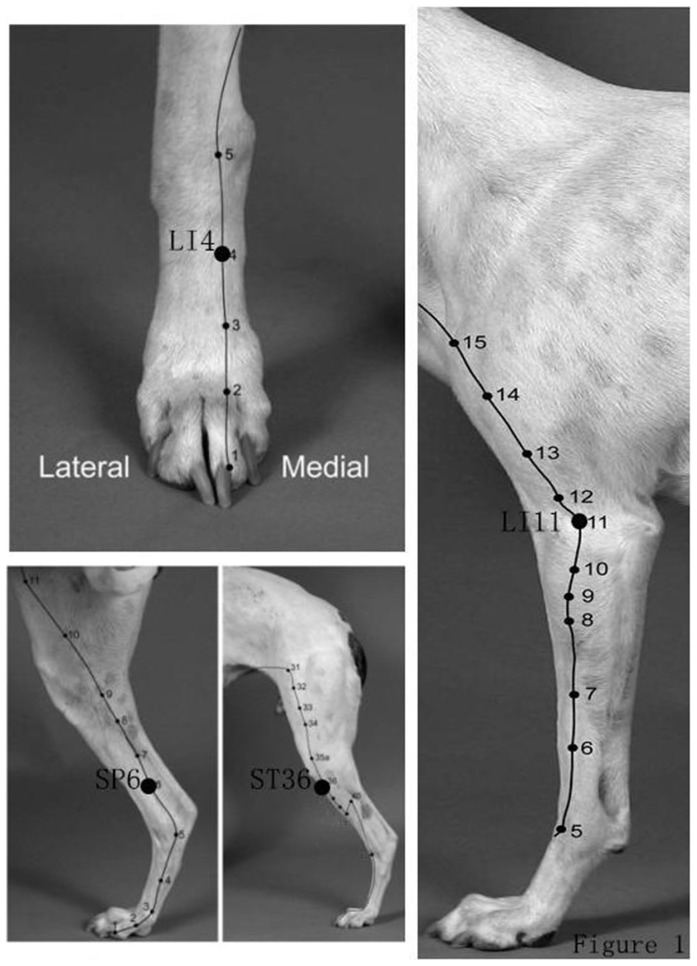
The location of all four acupuncture points.
Hegu (LI 4) is on the medial side of the thoracic limb between the second and third metacarpal bones at the midpoint of the third metacarpal bone. Quchi (LI 11) is on the lateral side of the thoracic limb at the lateral end of the cubital crease, halfway between the lateral epicondyle of the humerus and the biceps tendon with the elbow flexed. Sanyinjiao (SP 6) is On the medial side of the pelvic limb 3 cun proximal to the tip of the medial malleolus in a small depression on the caudal border of the tibia (opposite GB-39 on the lateral side). Zusanli (ST 36) is on the craniolateral aspect of the pelvic limb, 3 cun distal to ST-35, 0.5 cun lateral to the cranial aspect of the tibial crest, in the belly of the cranial tibialis muscle; this is a long linear point.